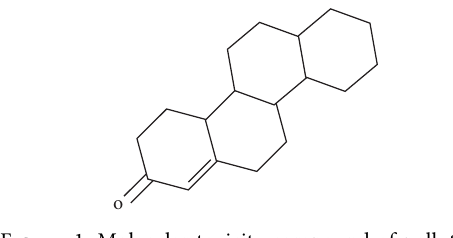
Figure 1: Molecular toxicity compound of pollution. Photoeletric molecule